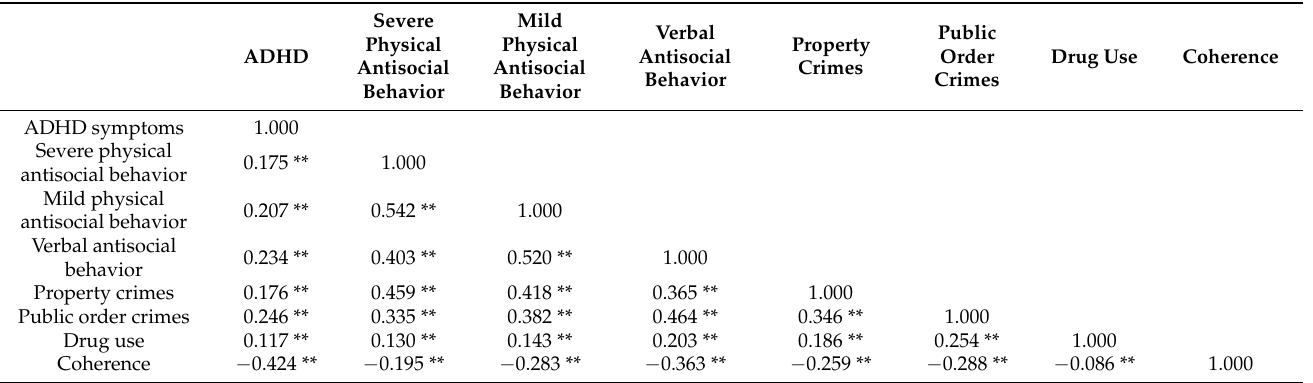
Property Crimes